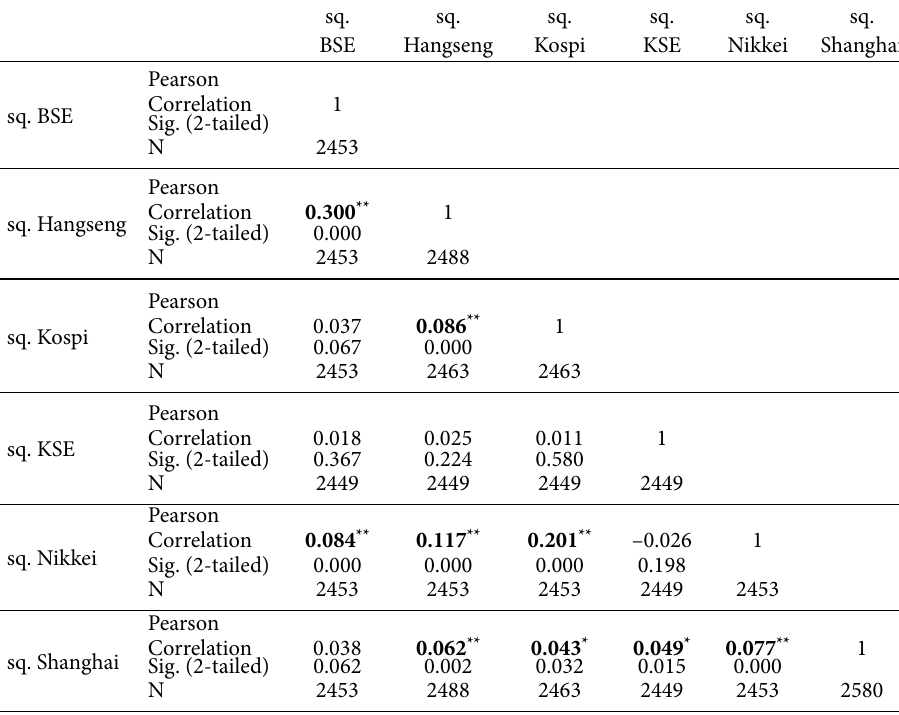
Table 4. Correlation analysis